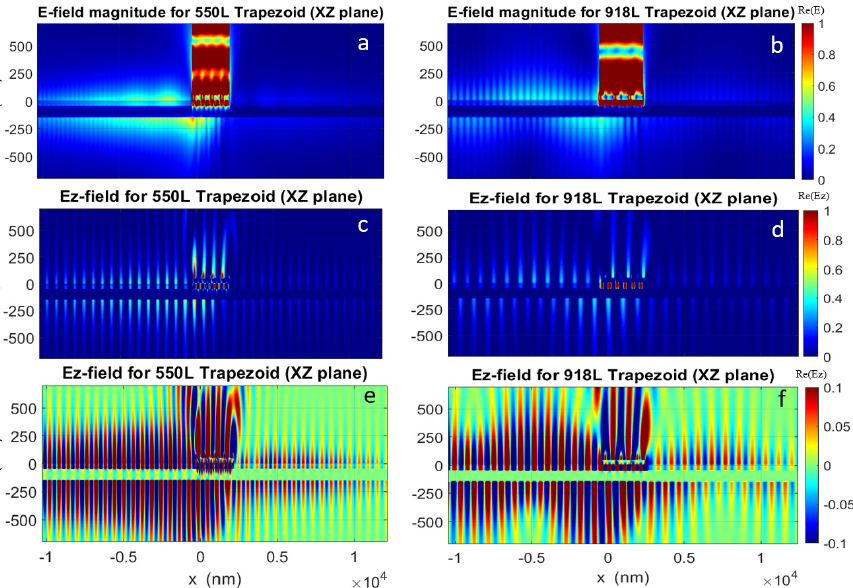
Figure 6. The SPP channeling from the symmetric and antisymmetric modes for up to 10 μ m beyond the trapezoid area in both the tip and base direction at (Y = 0) on the XZ plane: ( a ), ( c ) and ( e ) are four of the 550L trapezoids that were illuminated at 637 nm of λ ; ( b ), ( d ) and ( f ) are three of the 918L trapezoids that were illuminated at 990 nm of λ . The scaling of the Ez component was enhanced for the bottom row to show the symmetric SPP mode (for 550L) and antisymmetric SPP mode (for 918L) trapezoids via the SiO 2 –Cu bottom layer and Cu bottom layer–air interfaces.